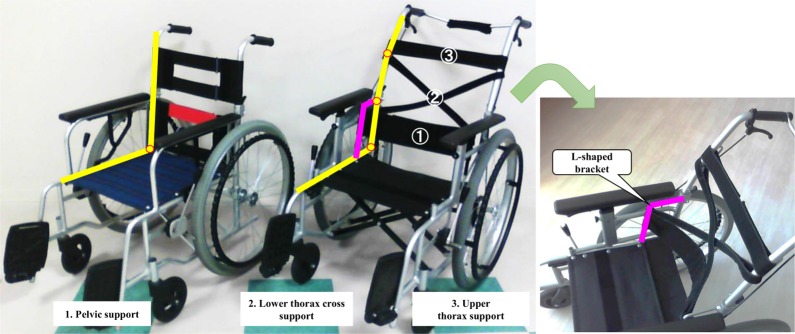
The difference in back support shapes.Left: C-WC. Right: P-WC. The sling seat of the back support was removed to unify the experimental conditions. The seat angles (i.e., the angle of orientation of the seat in the sagittal plane with respect to the horizontal plane as viewed from the side) were 2.9° for both wheelchairs. The post angle of the seat’s back support (i.e., the relative angle between the seat and the back support reference planes as viewed from the side) was 96° in C-WC, while the post angles of the seat’s back support in P-WC were 100° for PL, 110° for LT, and 121° for UT. The three belts can be set at several angles by changing the location of the fastener.